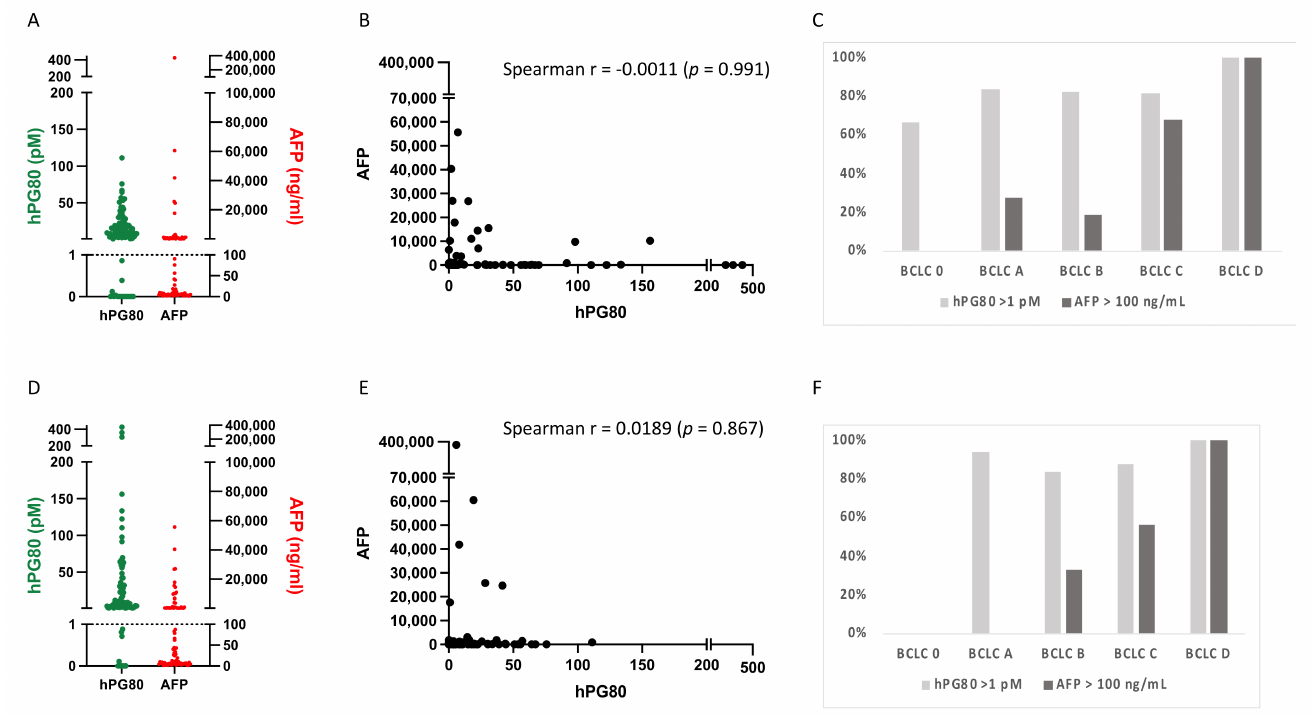
Figure 2. Characteristic of the training and validation cohorts. A to C, the training cohort. ( A ) Plasma hPG 80 and AFP levels in HCC patients ( n = 84). A cutoff value of 1 pM for hPG 80 was set based on the limit of detection of hPG 80 . The cutoff value for AFP was set at 100 ng/mL. ( B ) Correlation between hPG 80 and AFP levels in HCC patients was evaluated by the Spearman correlation coefficient. ( C ) hPG 80 levels according to the BCLC stratification. D to F, the validation cohort. ( D ) Plasma hPG 80 and AFP levels in HCC patients ( n = 84). A cutoff value of 1 pM for hPG 80 was set based on the limit of detection of hPG 80 . The cutoff value for AFP was set at 100 ng/mL. ( E ) Correlation between hPG 80 and AFP levels in HCC patients was evaluated by the Spearman correlation coefficient. ( F ) hPG 80 levels according to the BCLC